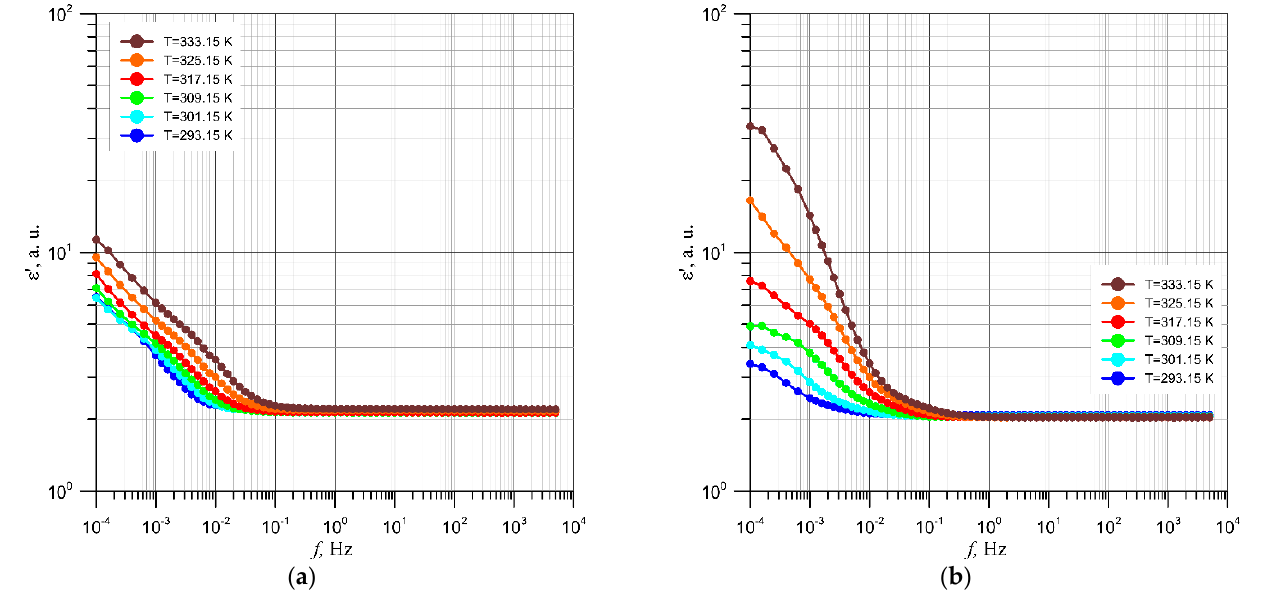
Figure 4. Frequency dependencies of the dielectric permittivity of mineral insulating oil with a mois ‐ ture content of 5 ppm—( a ) and moistened mineral oil—( b ) at temperatures from 293.15 K to 333.15 K in steps of 8 K.